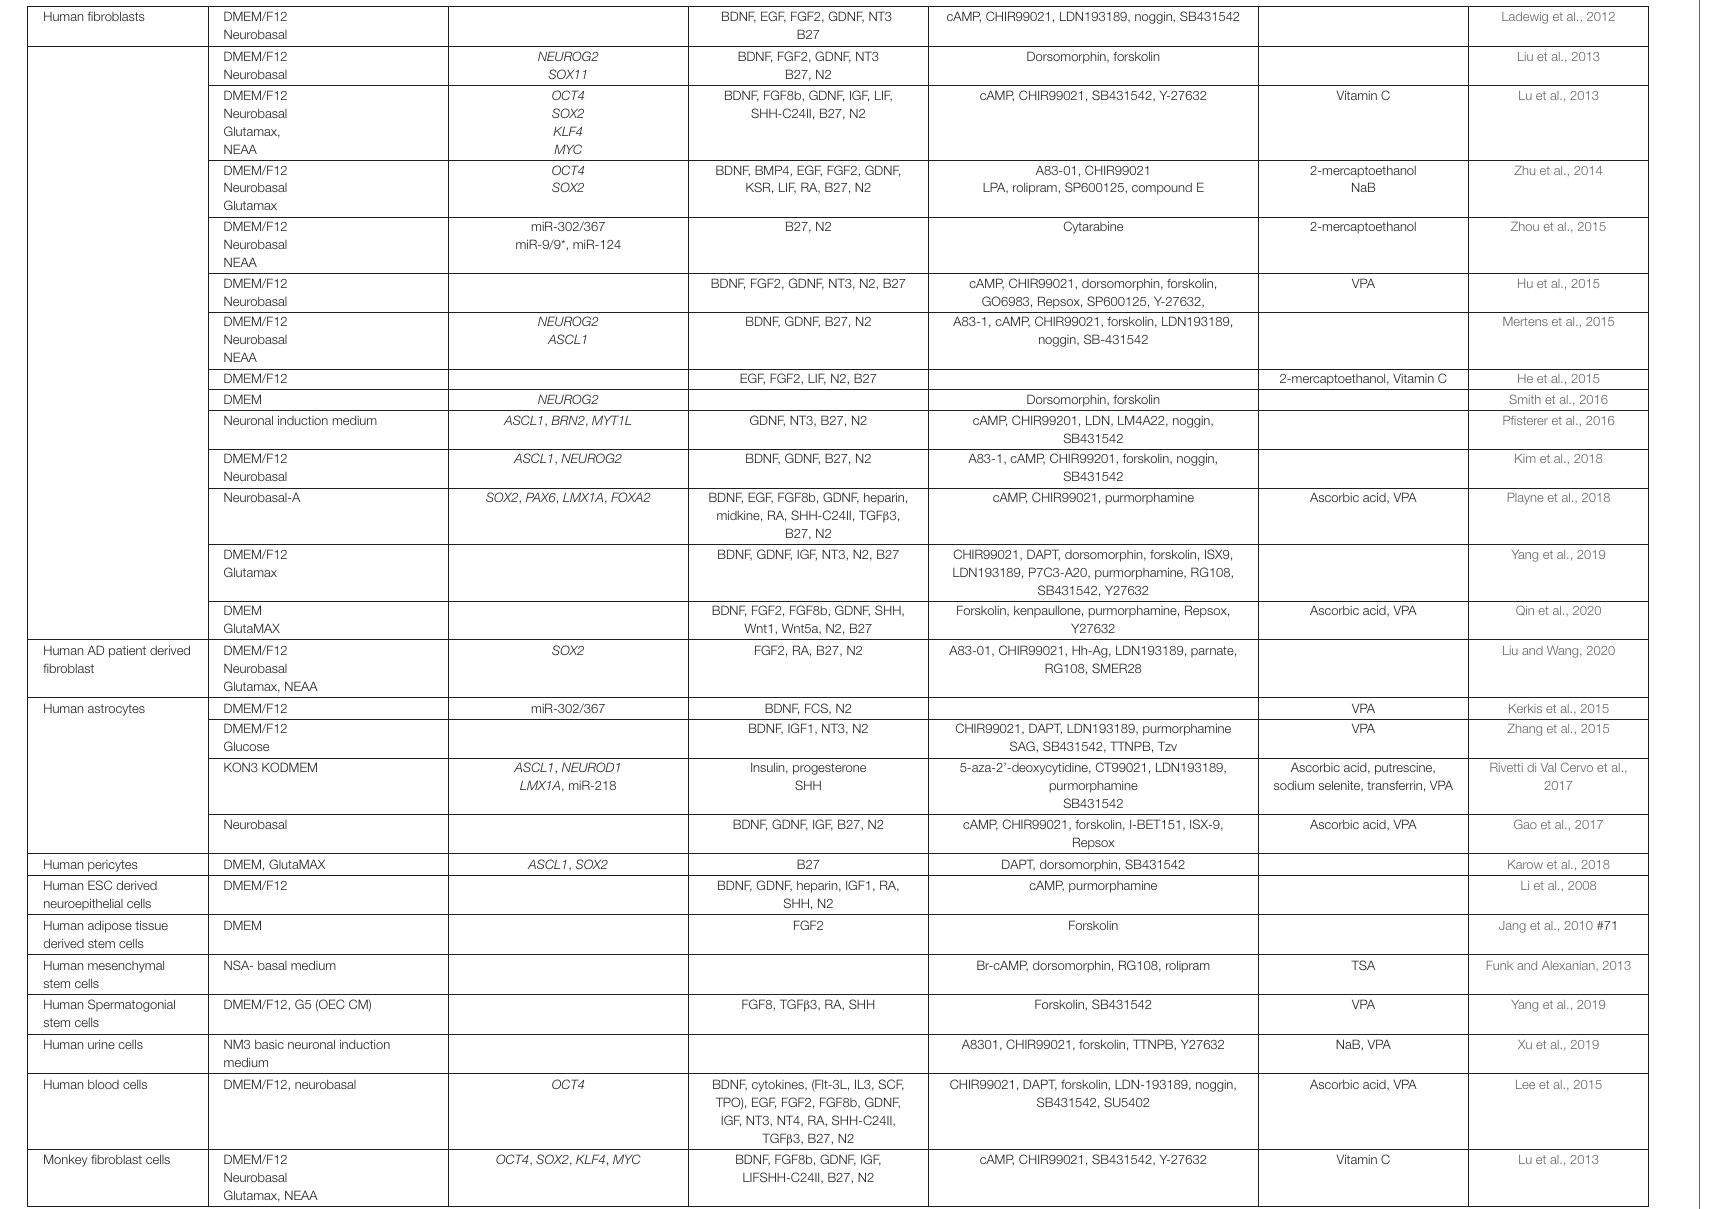
TABLE 3 | Small molecules used in iN lineage conversion strategies in human